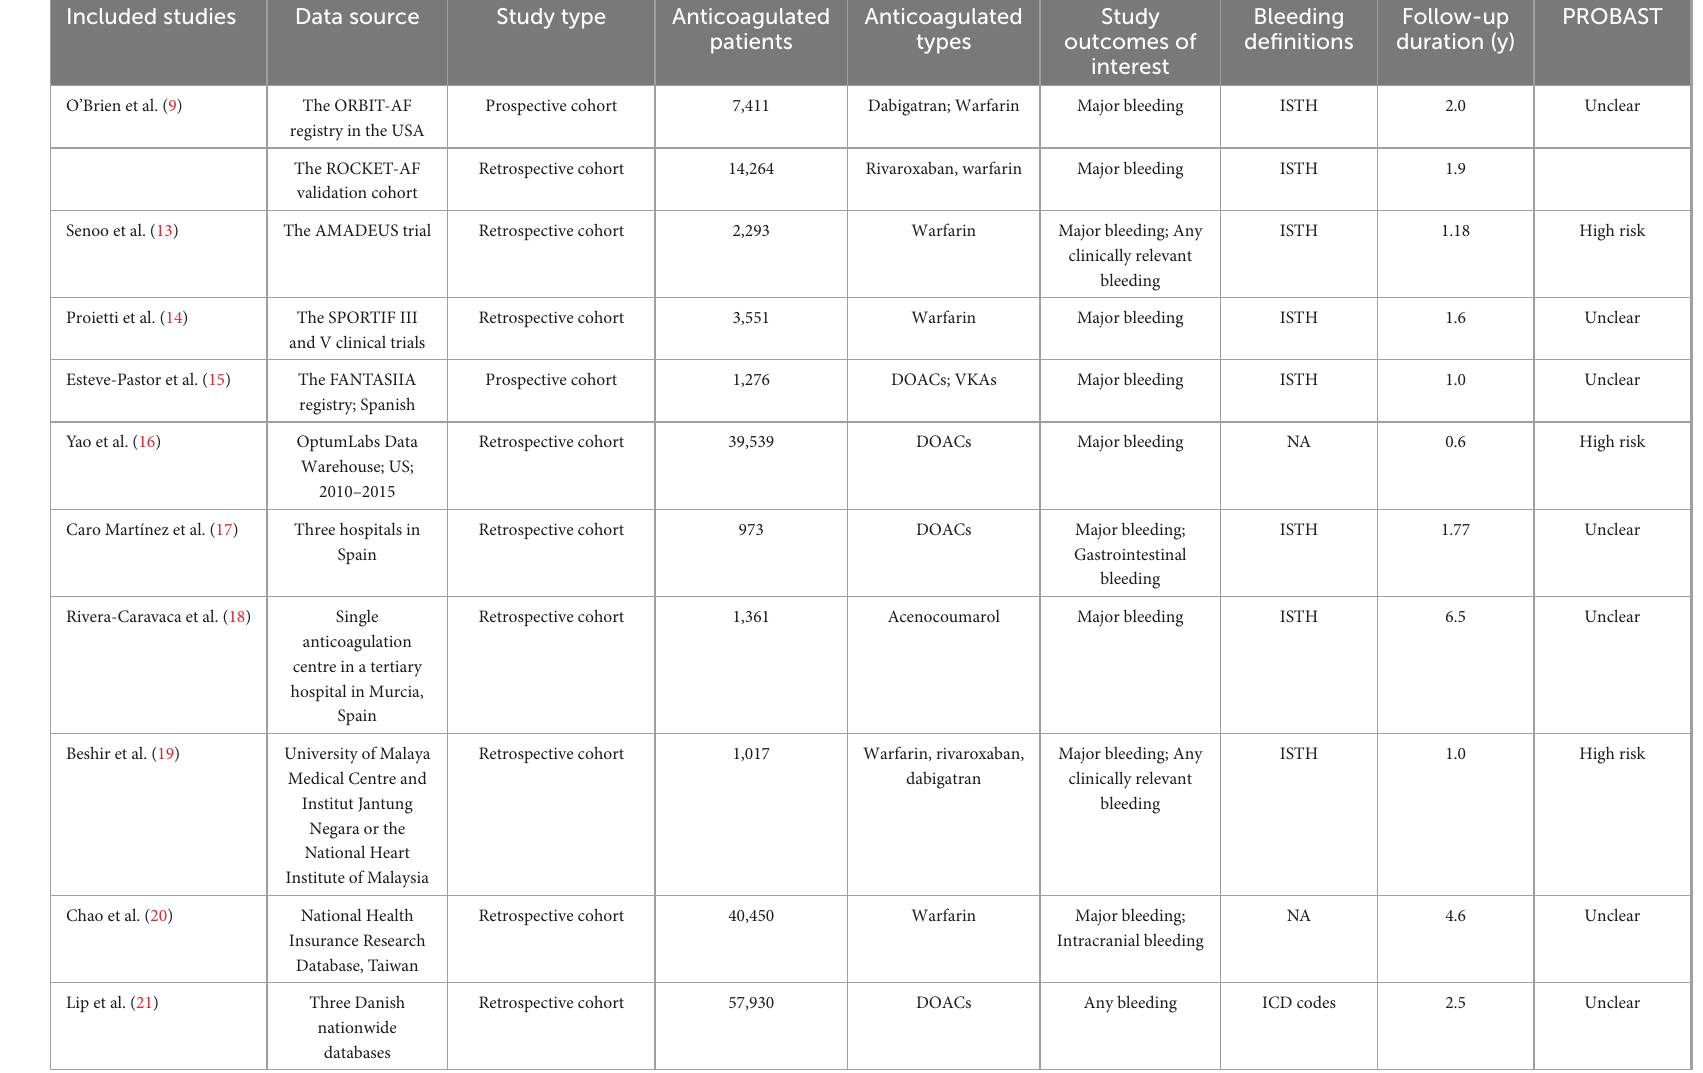
TABLE 1 Baseline characteristics of the included studies containing the HAS-BLED and ORBIT